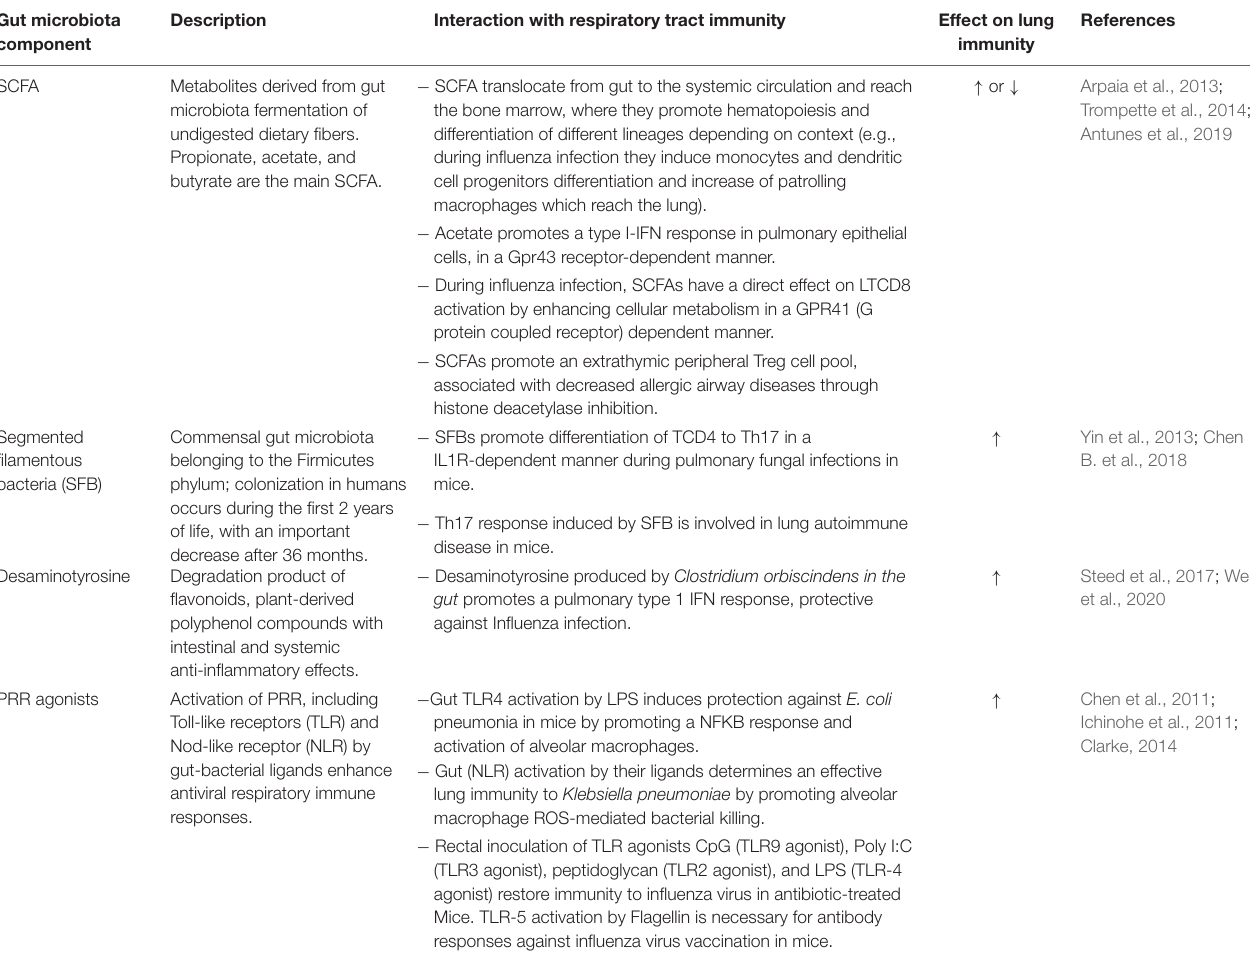
TABLE 6 | Key factors involved in the modulation of lung immunity through the Gut-Lung